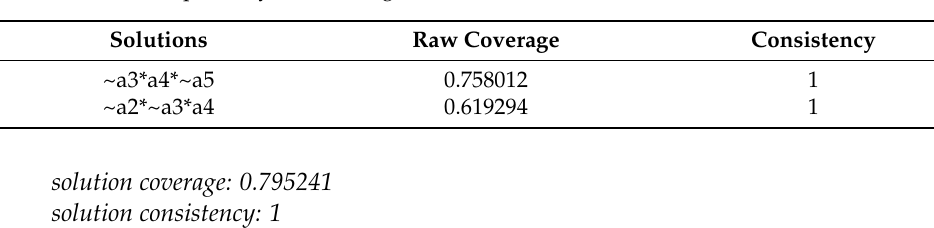
Table A18. Failure pathways (ultimate goal)- The mark * resembles